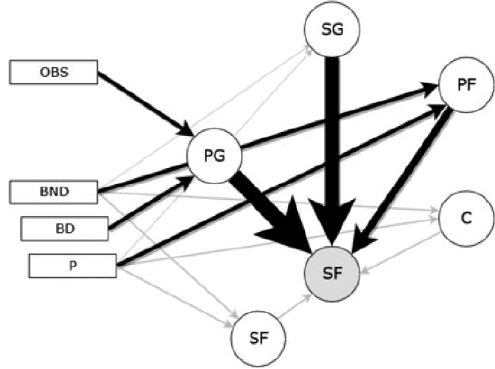
Fig. 3 Midfielder pass and catch combination